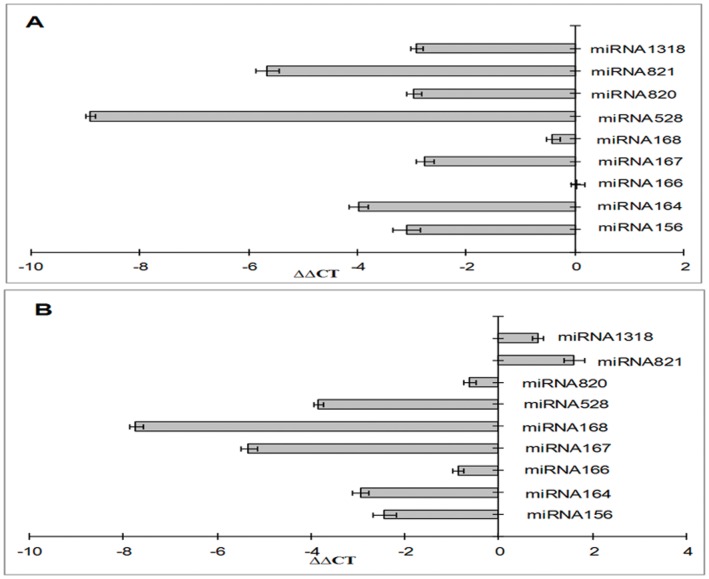
ΔΔCT values of low-N tolerant miRNAs in leaves (A) and roots (B) of IC-547557 over Vivek Dhan.Significantly varied miRNAs were selected on basis of ΔΔCT ≥3 or ≥ −3. Values are means of duplicates of three biological replicates. SE is shown by bar. ΔΔCT = (ΔCT –VIVEKDHAN-(Δ CT- IC-547557 ) & ΔCT = CTmiR -CTmiR159.